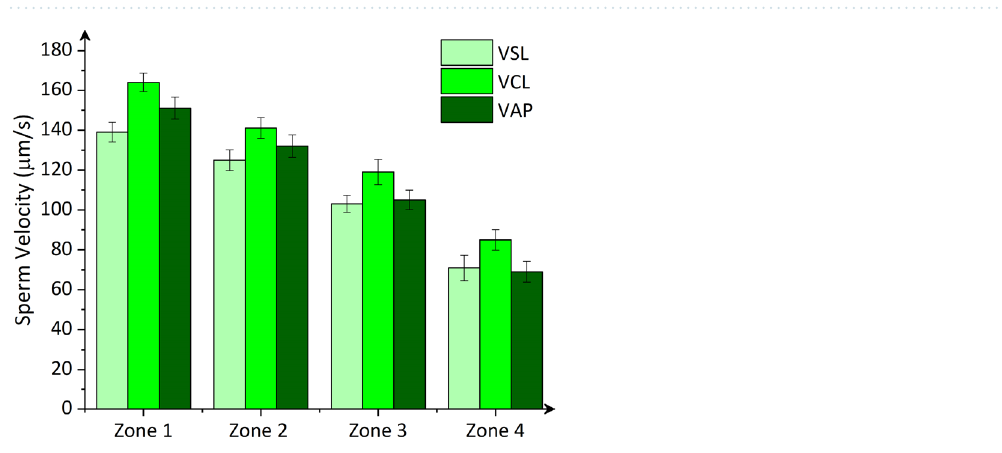
Figure 5. Straight line velocity (VSL), curvilinear velocity (VCL) and average path velocity (VAP) of human sperm isolated in each separation zone. Values are reported as mean ± s.d. (n ≥